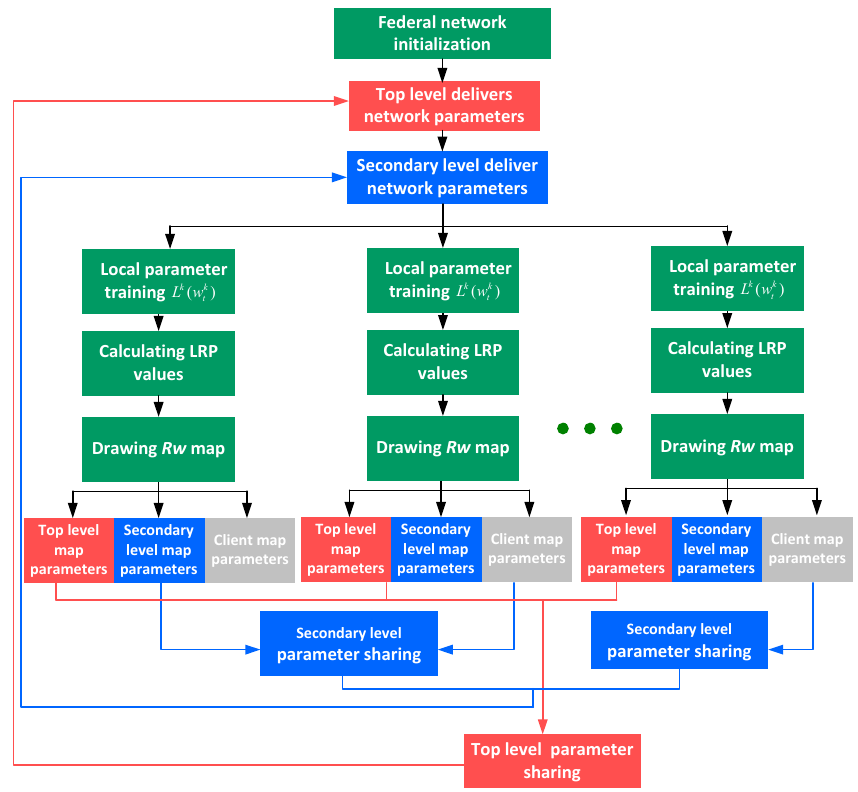
Figure 7. The flow chart of the proposed i -MFN algorithm.